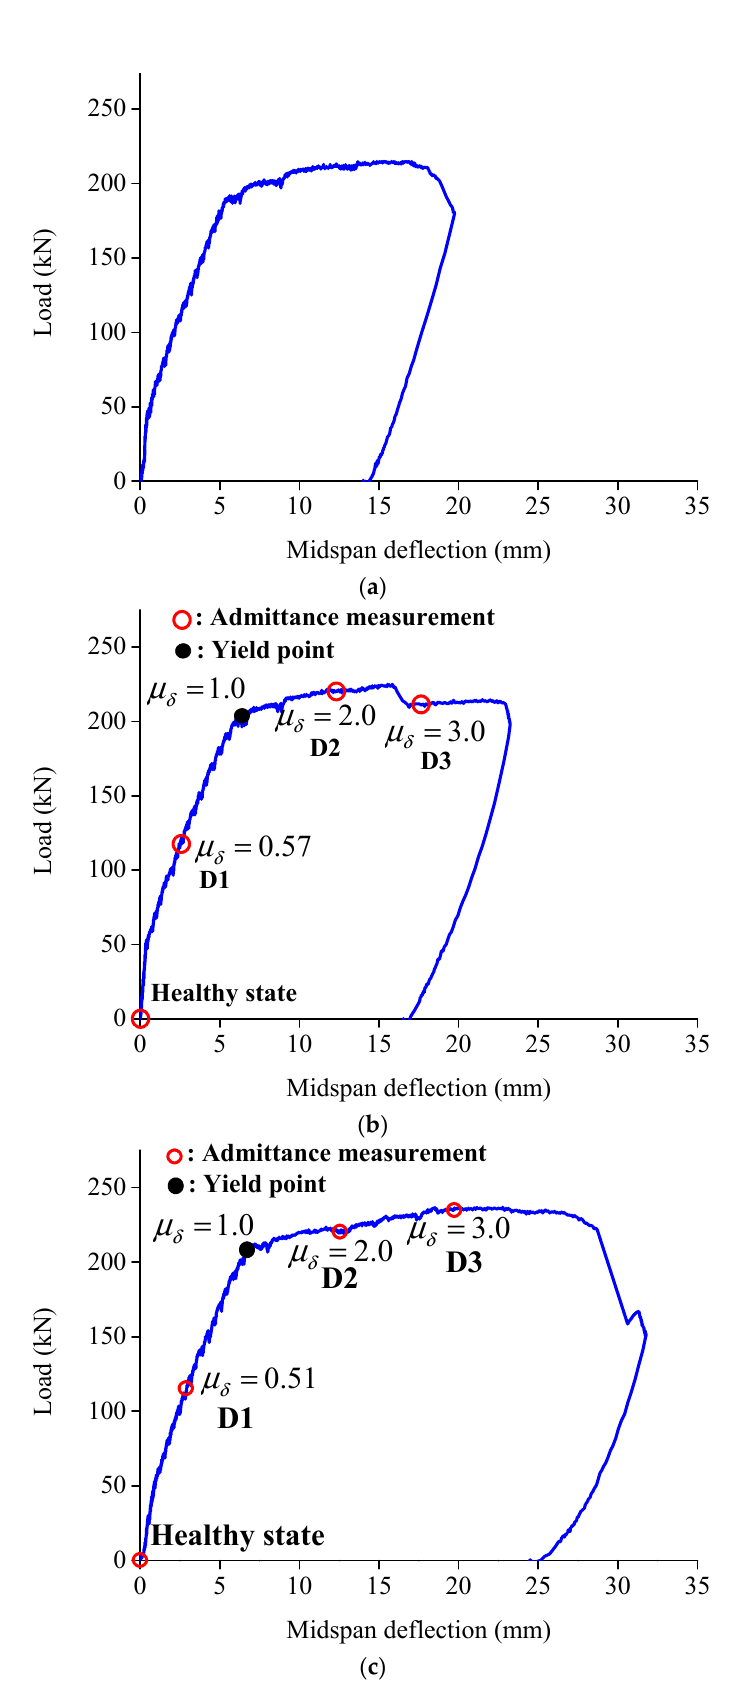
Figure 6. Loadmidspan deflection of the three test specimens: ( a ) RC beam; ( b ) BE1; ( c ) BE2.